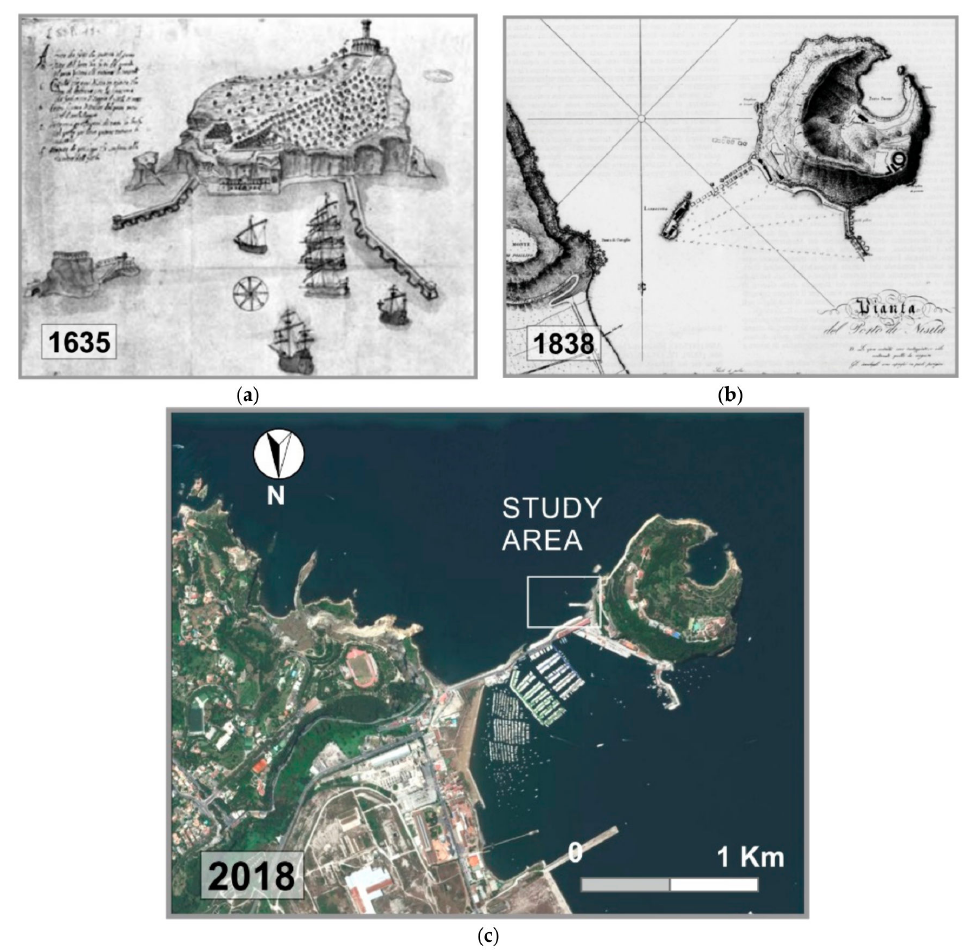
Figure 3. ( a ) Pictorial view of Nisida harbour in 1635 by B. Picchiatti where the Roman opus pilarum is clearly visible; ( b ) historical map “PIANTA DEL PORTO DI NISITA” 1838, where the pilae are still intact and emerged; and ( c ) present-day aerial